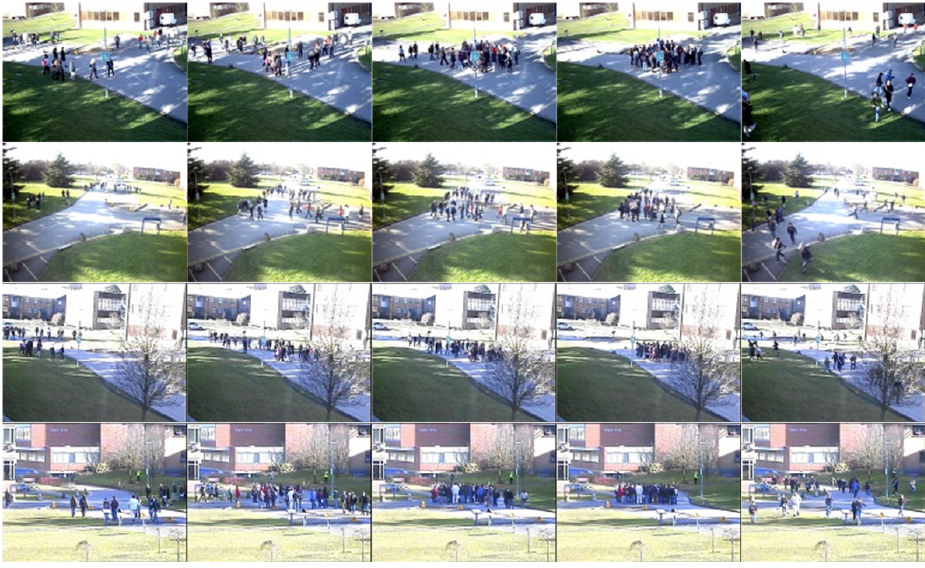
Figure 5 . The examples of the PETS2009 dataset. Figure 5. The examples of the PETS2009